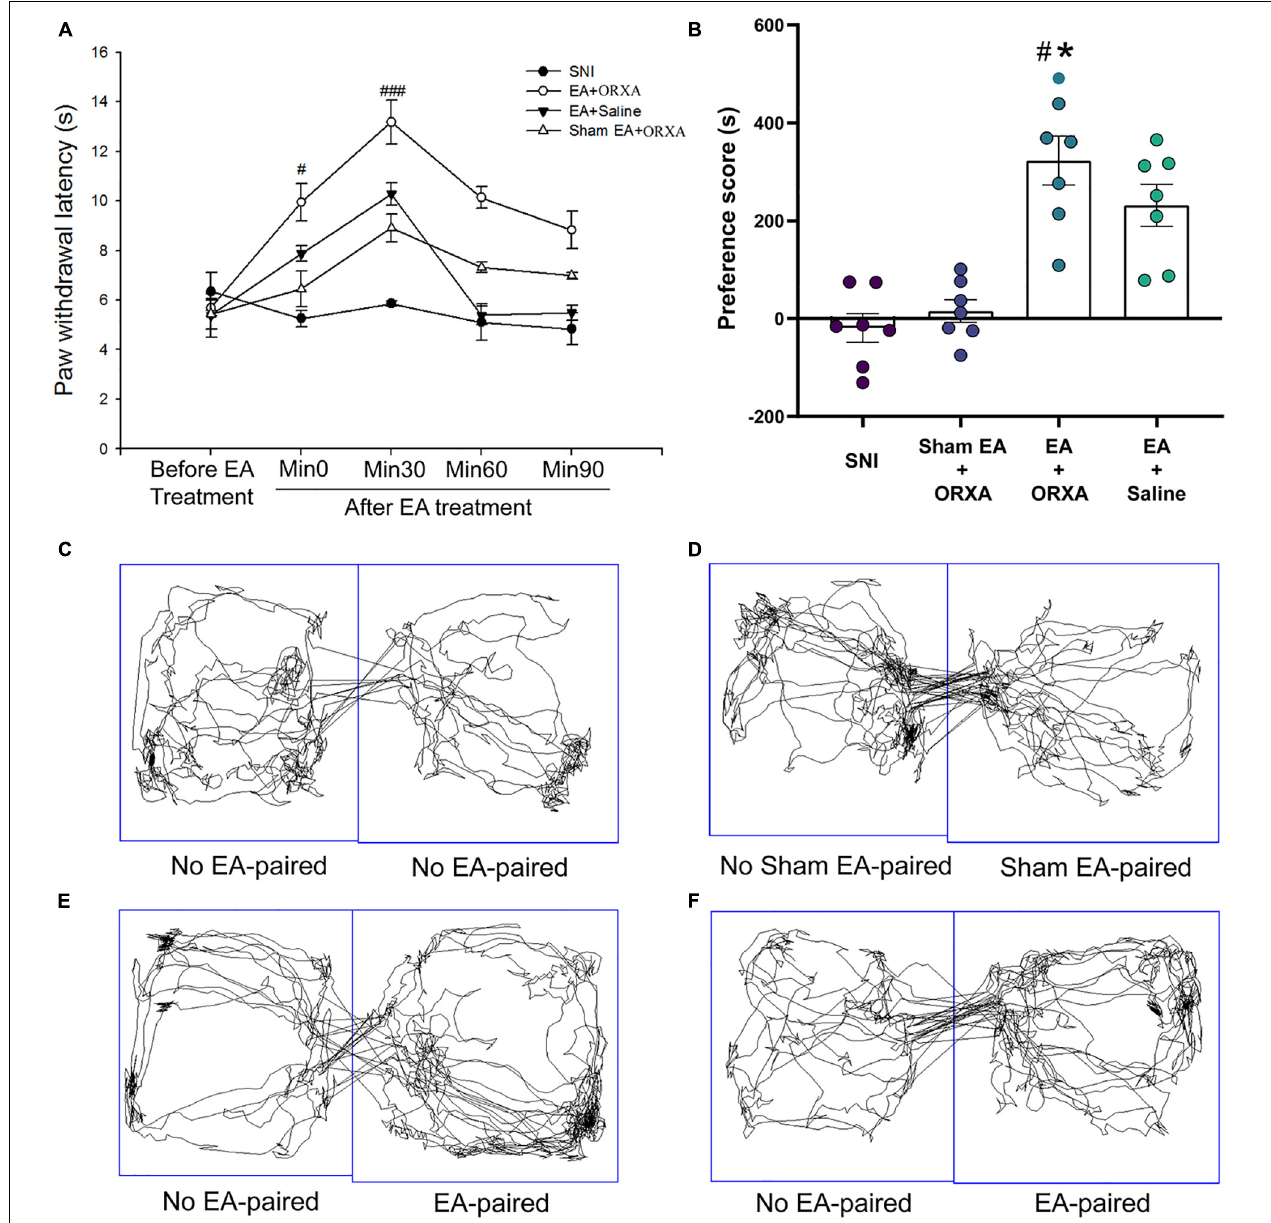
FIGURE 8 | The potential effects of combinations of EA and low-dose orexin-A on the thermal hyperalgesia and CPP scores. (A) Immediate effects of EA and low-dose orexin-A on the thermal hyperalgesia among the various groups. ### p < 0.05 vs. SNI group, EA + Saline, and Sham EA + ORXA group. (B) The preference scores after CPP testing among the different groups. # p < 0.01 vs. the SNI group; * p < 0.05 vs. the EA + saline group. Real-time movement traces during CPP test: (C) SNI group; (D) Sham EA + ORXA group; (E) EA + ORXA group; and (F) EA + saline